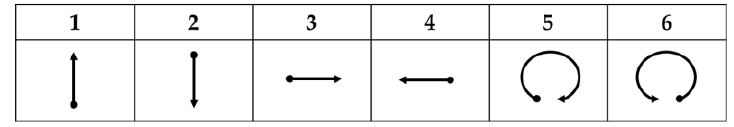
Figure 9. Patterns of six hand gestures. Table 1. Gesture-referent mapping.